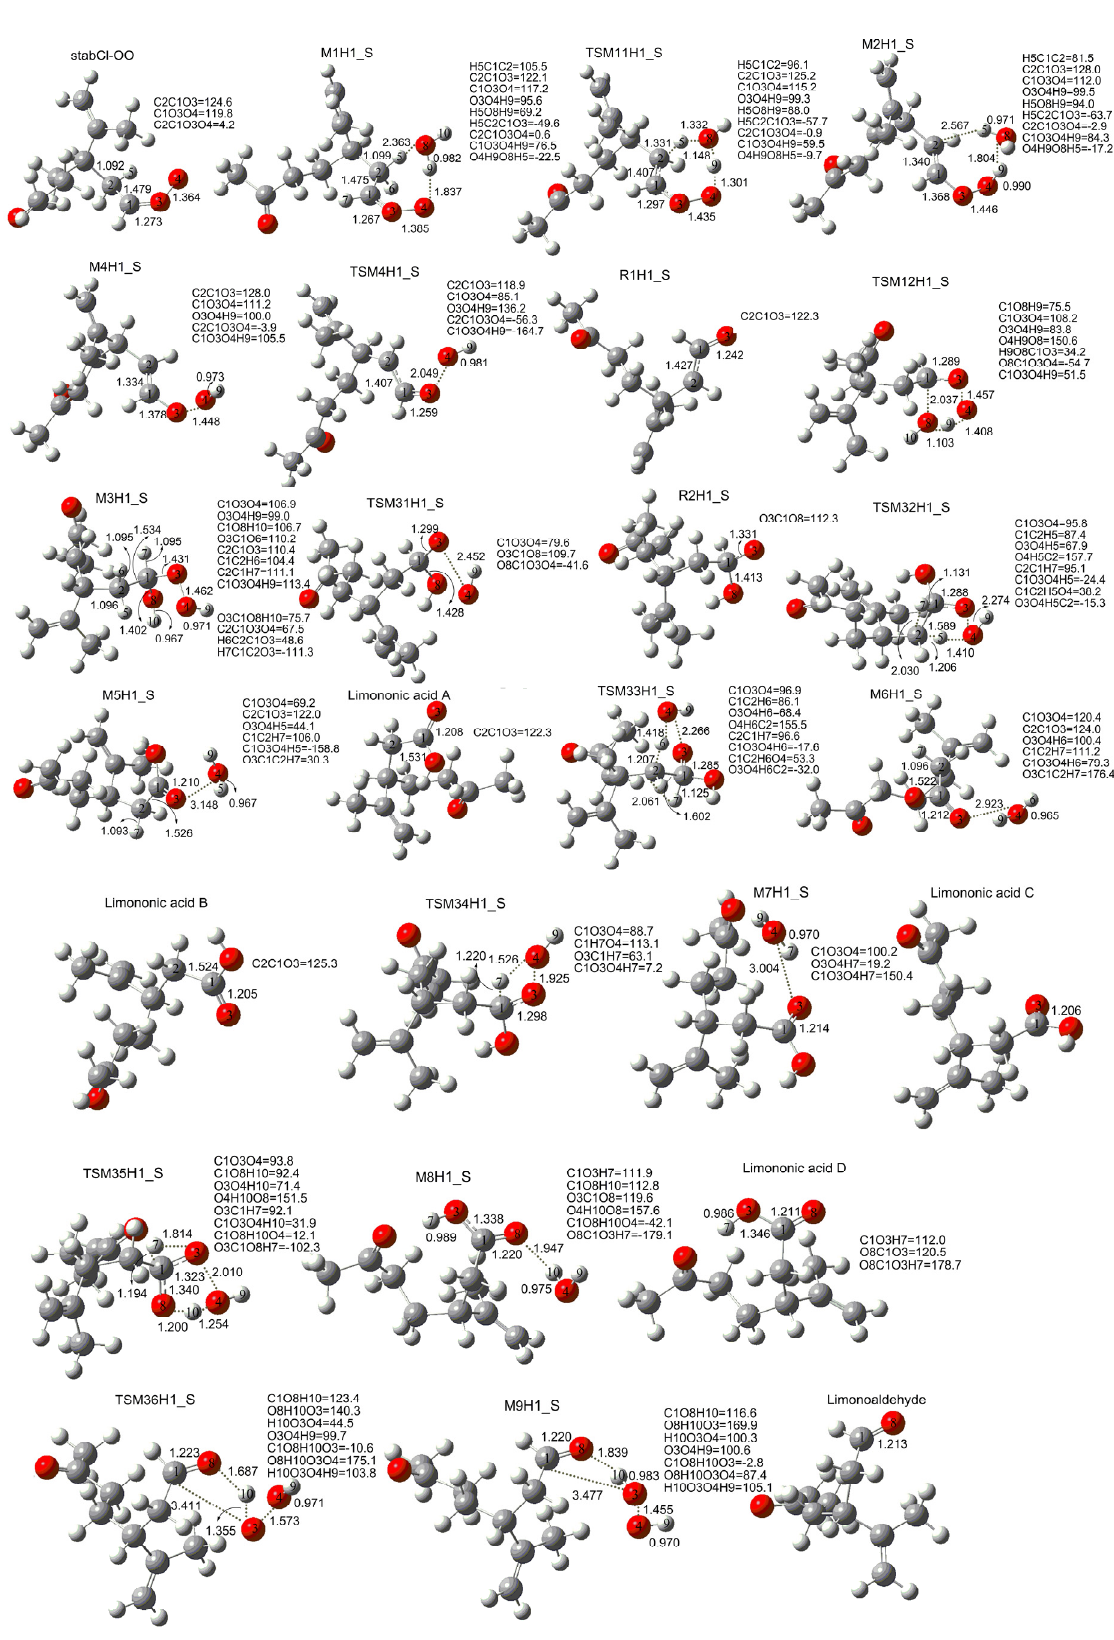
Figure 1. Geometries of the stationary points in the stabCI-OO + H the B3LYP/6-31G(d,p) level of theory. Bond lengths and intermolecular distances are given in